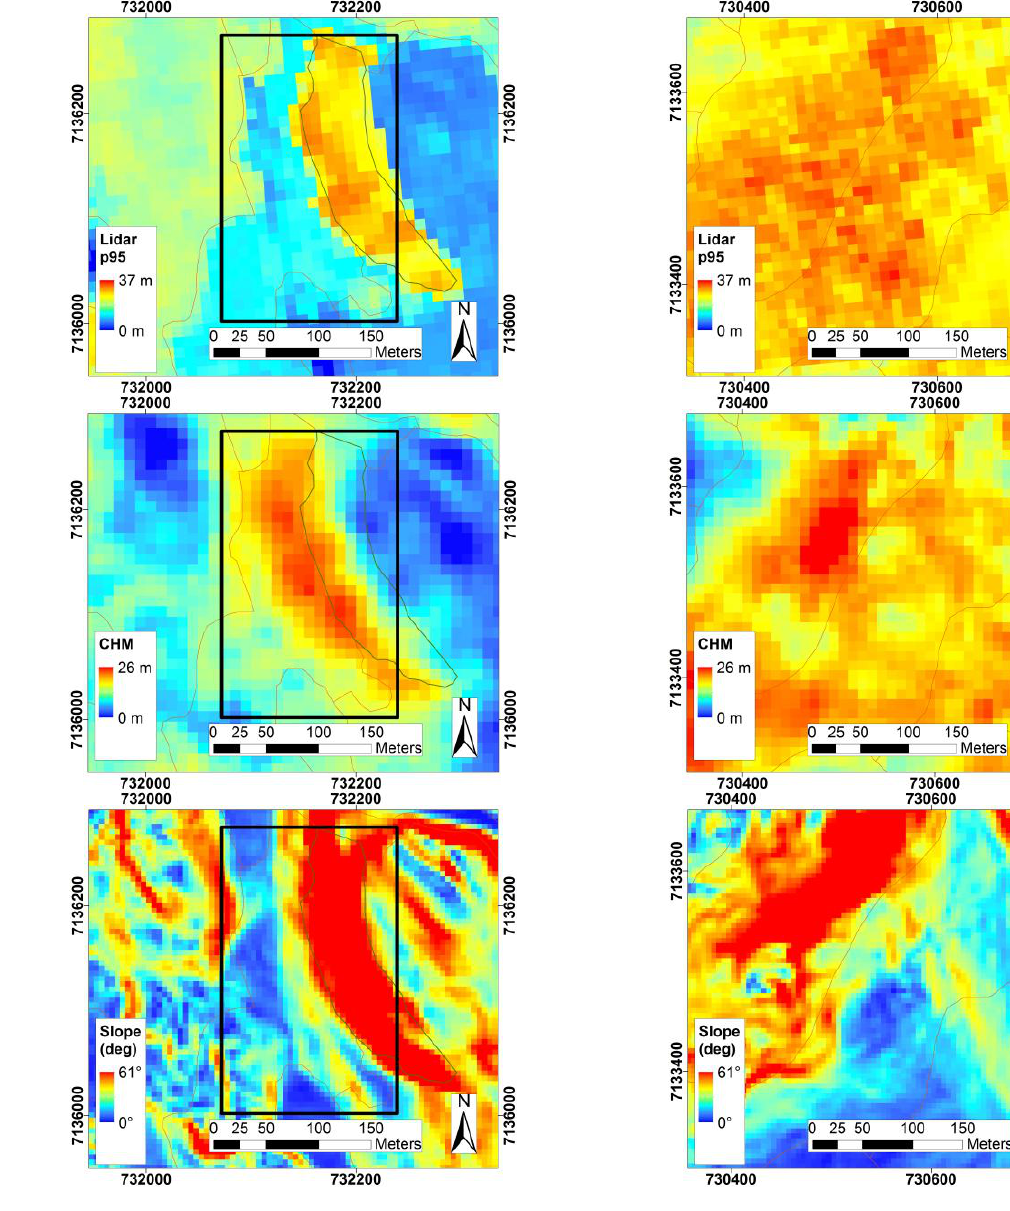
Figure 7. Topography affected stands at Krycklan. In the foreslope ( Left ), the central stand with low heights gets high heights shifted into its stand caused by the slope located in the stand to the right (61°). In the backslope ( Right ) this effect is negligible. Top : ALS percentile 95 height raster. Middle : TerraSAR-X derived height raster. Bottom : Slope raster derived from ALS data. The TerraSAR-X images are acquired from the left side in these